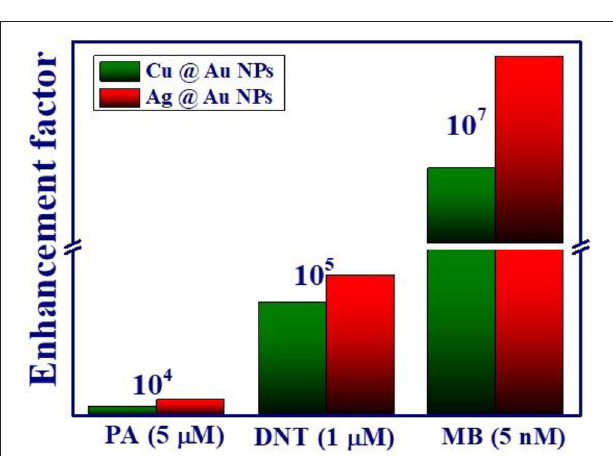
FIGURE 11 | A comparison of the SERS enhancement factors obtained with Ag@Au and Cu@Au NPs for different analyte molecules used in this study.